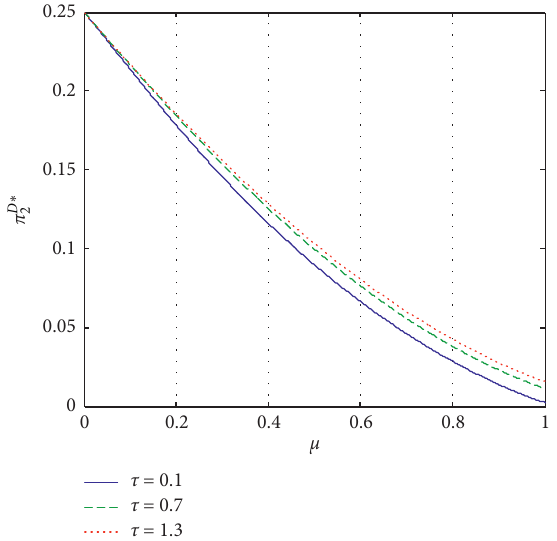
Figure 4: The changes of low-quality firm’s profit with μ under different values of τ .